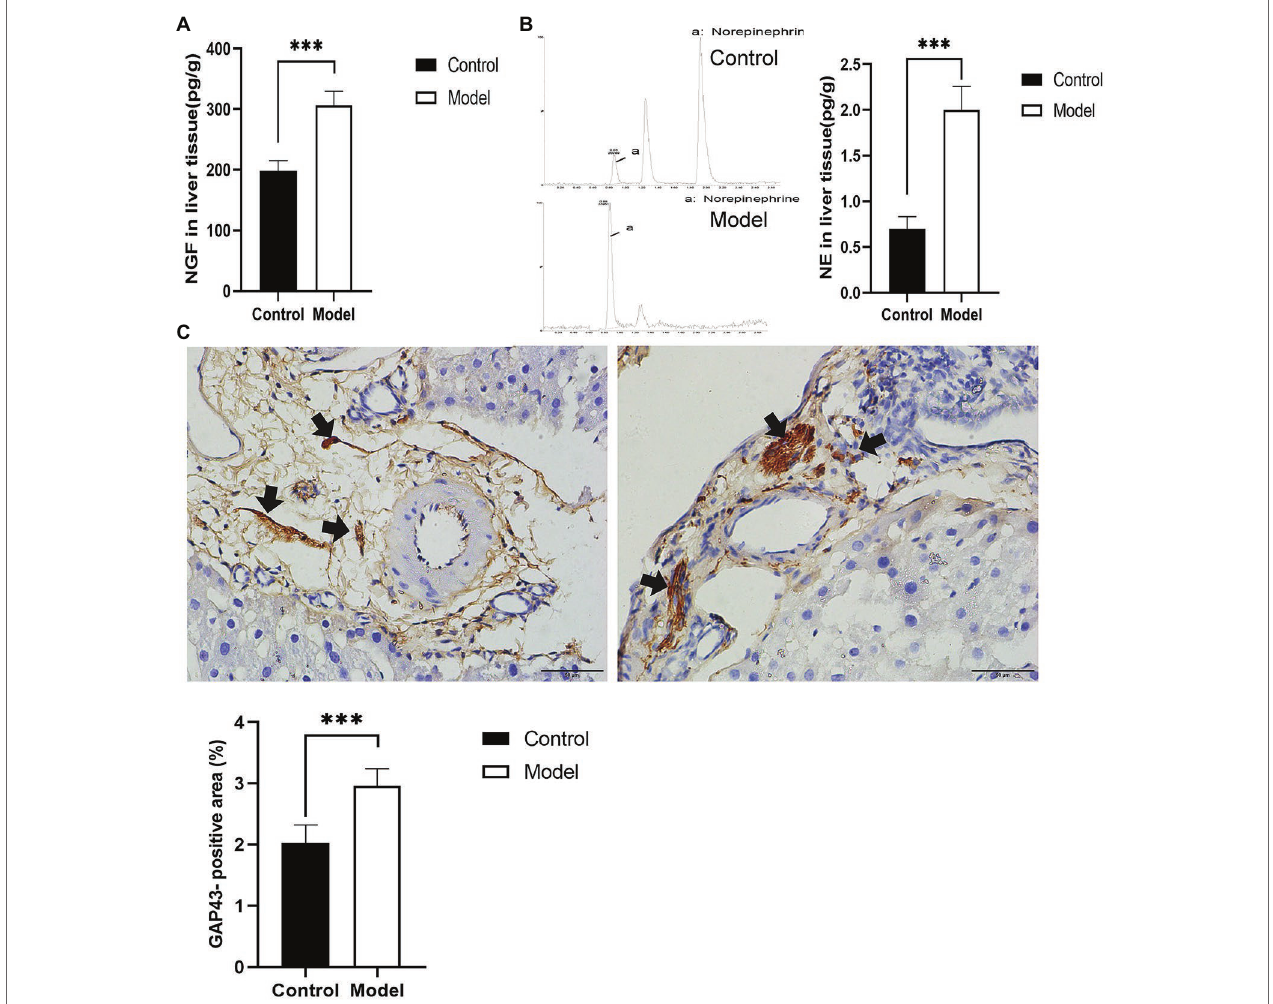
FIGURE 3 | Determination of nerve growth-related indexes in liver tissue. (A) Nerve growth factor (NGF) was determined by ELISA in liver tissues. (B) Norepinephrine (NE) in liver tissues was quantified by high-performance liquid chromatography-tandem mass spectrometry (HP-LC-MS/MS), presenting an increase in the model group. (C) Immunohistochemical staining of growth-associated protein-43 (GAP43) was used to assess nerve growth (scale bar: 50 μ m). The results were obtained from two independent experiments and are expressed as the mean ± SD, n = 8 per group, *** p < 0.001. NE,